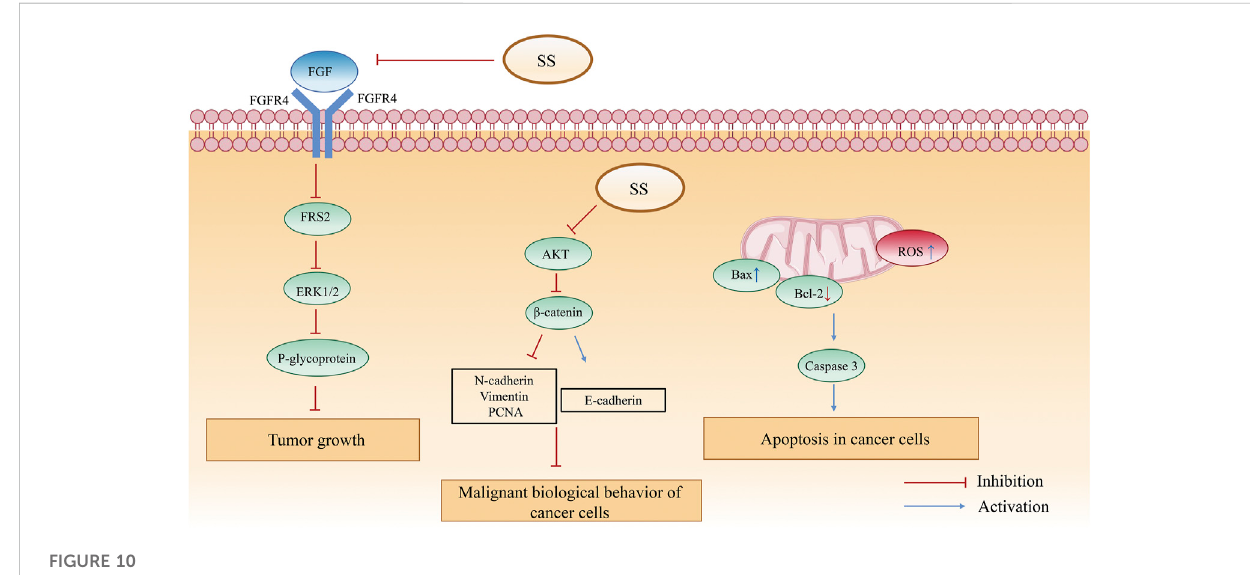
FIGURE 10 Signaling pathways of anti-tumor effect of